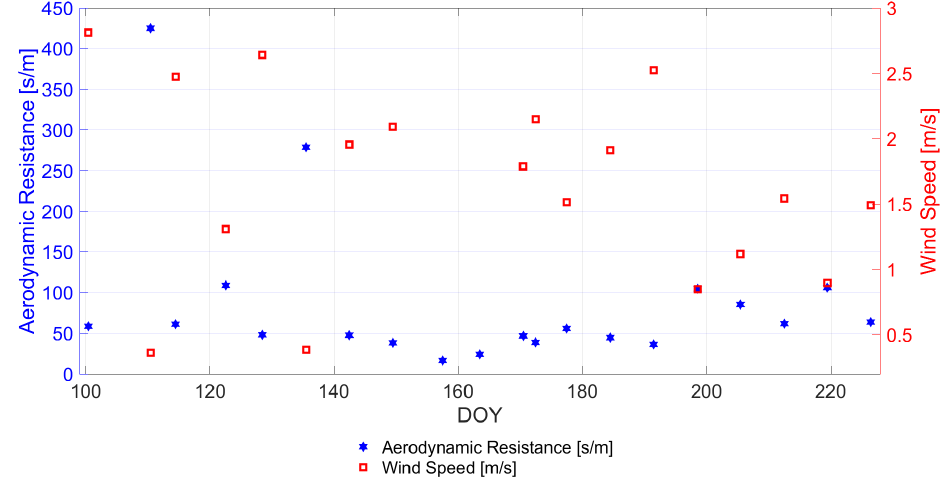
Figure 8. Comparison of the in situ-measured wind speed [ms − 1 ] and the calculated aerodynamic resistance R A [sm − 1 ] of the winter wheat canopy from the model of Monteith (1963) (adopted in Choudhury and Idso, 1985a) under incorporation of vegetation height observations (cf. Fig. 1) along days of year (DOY).